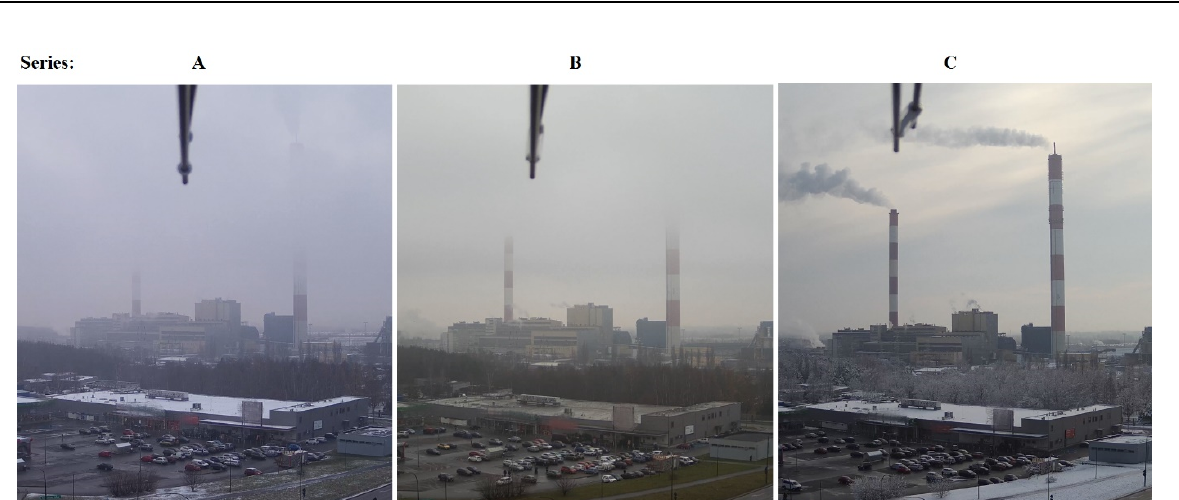
Figure 4. Pictures towards the EC4 showing the weather conditions during the series of measurements.